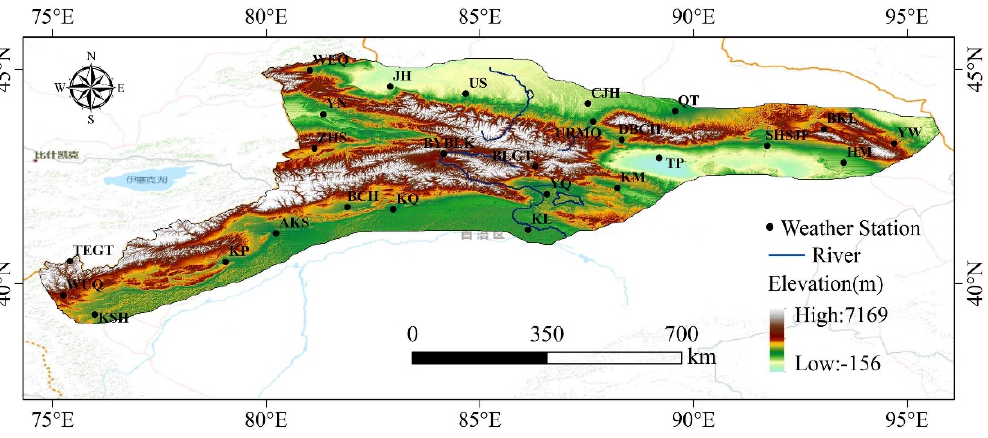
Figure 1. Map of the study area.